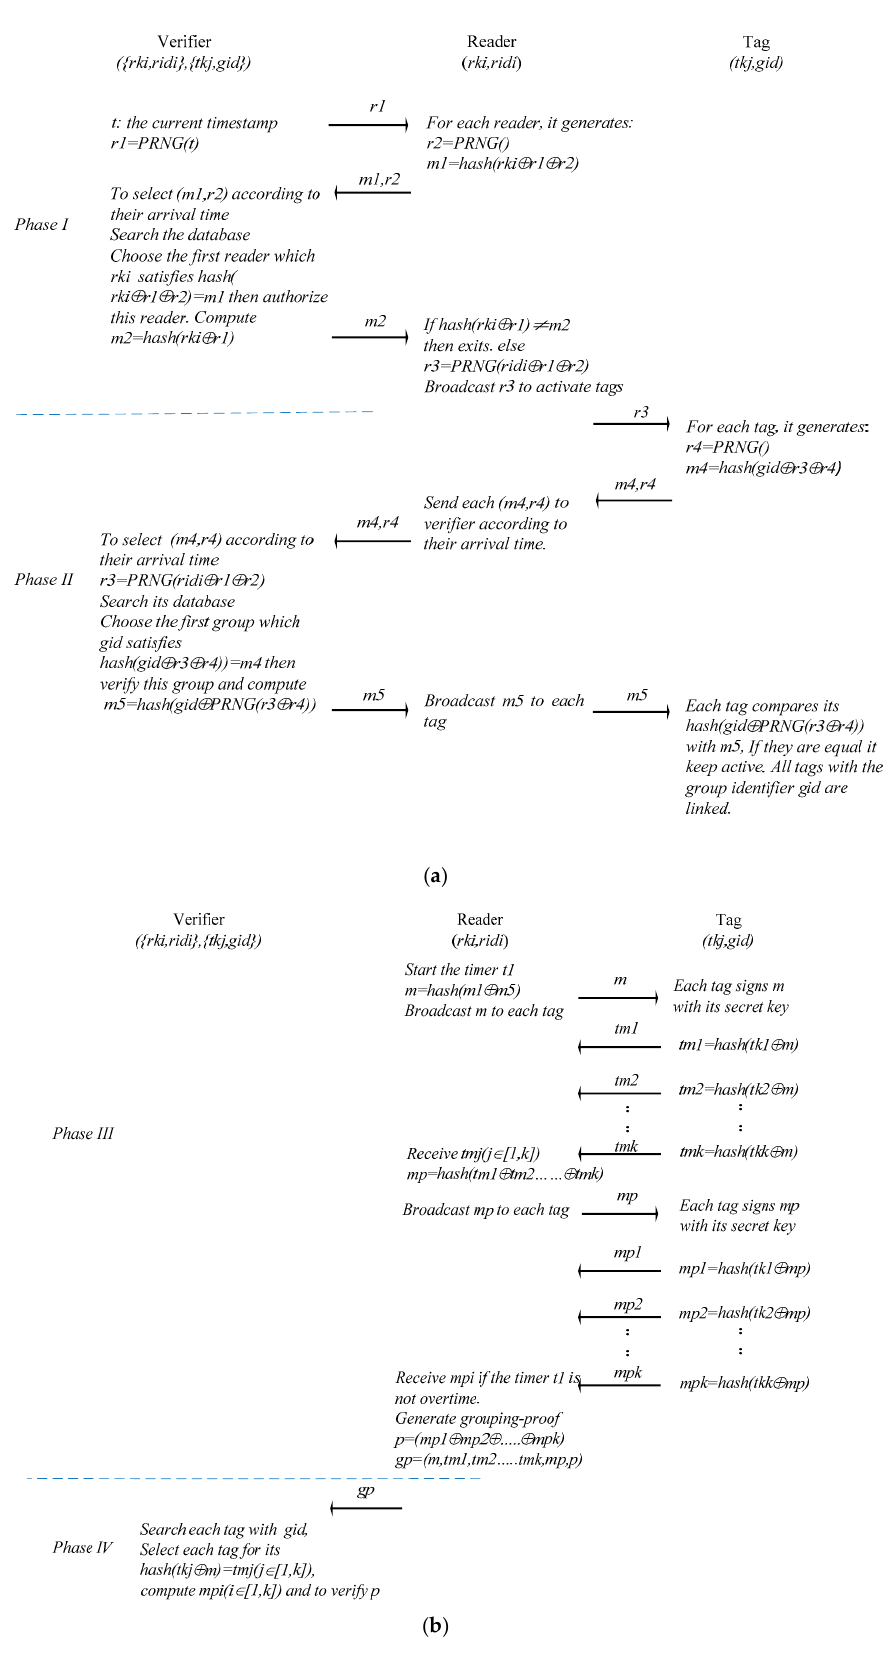
Figure 2. ( a ) The diagram of our proposed protocol under passive mode; ( b ) The diagram of our proposed protocol under passive